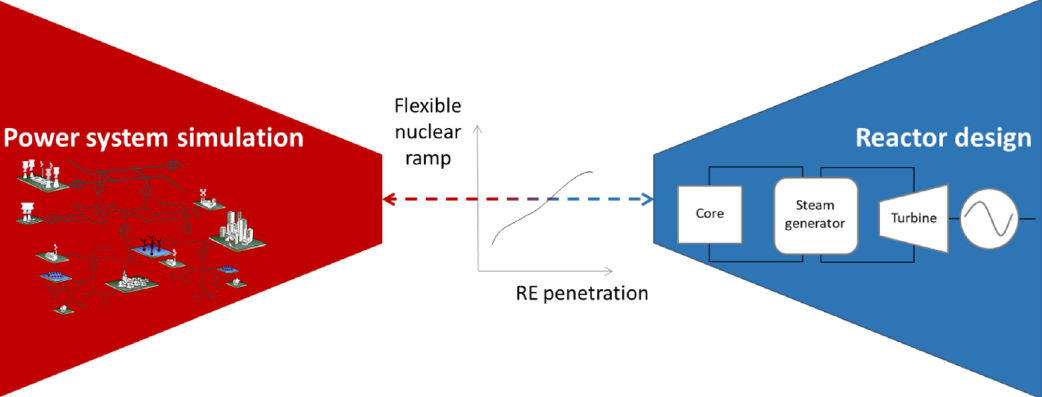
Fig. 1. Scheme of the